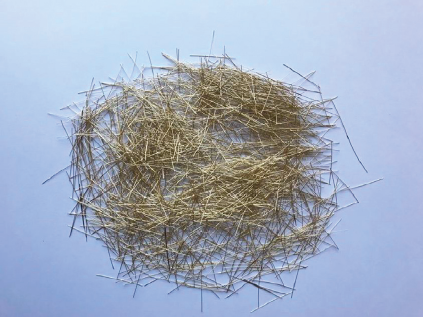
Figure 1: Steel fiber used for the HSFRC mixture